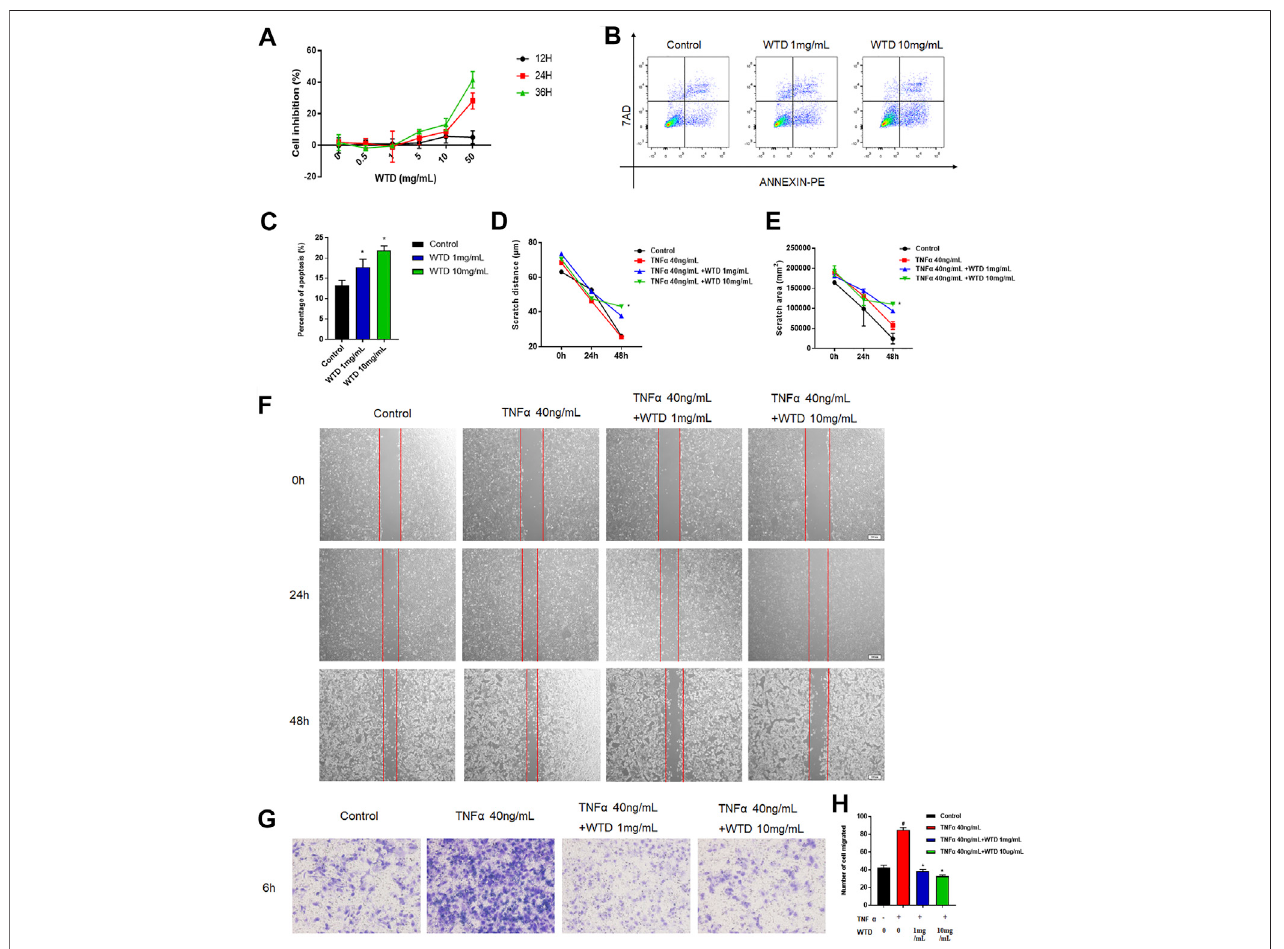
FIGURE 4 | The effects of WTD on the proliferation, apoptosis, migration and invasion of MH7A cells. (A) Effects of WTD intervention on MH7A cell proliferation at 12, 24, and 36 h (B – C) Effects of MH7A cell apoptosis after WTD intervention. (D) Effects of MH7A cell migration at 0, 24, and 48 h after WTD intervention. Statistical diagram of € scratch distance and (F) scratch area. (G) Effects of MH7A cell invasion after WTD intervention. (H) Statistical results of the number of migrated cells. The results were expressed as mean ± SE. All experimental results were repeated three times. # p < 0.05, ## p < 0.01 versus the control group; * p < 0.05, ** p < 0.01 versus the TNF α 40 ng/ml